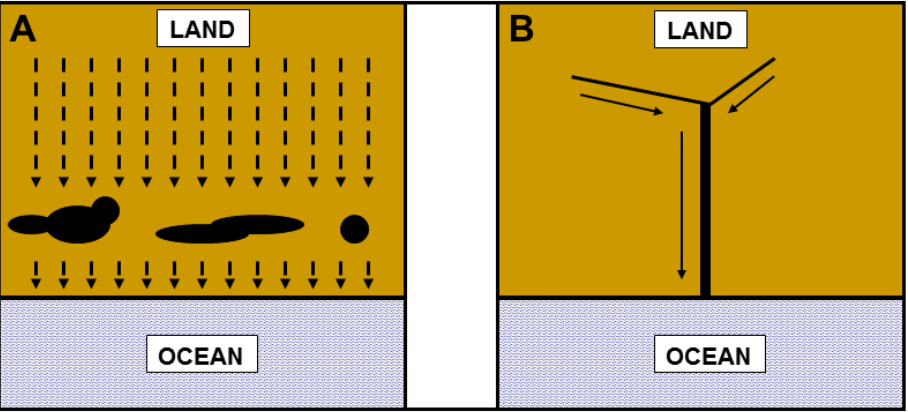
Figure 5. The plan view difference in cave orientation and configuration between diffuse flow in an eogenetic karst aquifer in a coastal setting dominated by diffuse flow ( A ) and a telogenetic continental aquifer dominated by turbulent conduit flow ( B ). In ( A ), cave voids are flank margin caves, which are irregular in shape, parallel to the strike of the coast, and are embedded in a diffuse flow system. In ( B ), cave voids are epigenic stream caves, which are linear and regular in shape, oriented perpendicular to the coast (in their distal portions), and are part of a turbulent flow regime. Field work on telogenetic coastal karst aquifers has demonstrated that flank margin caves can still form in the gaps between conduit flow paths (e.g., [21].